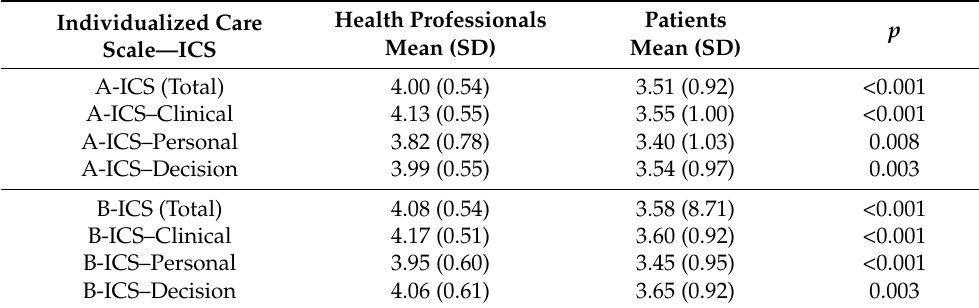
Table 3. Health professionals’ and patients’ assessments of individualized care at the ICS dimension and sub-scale